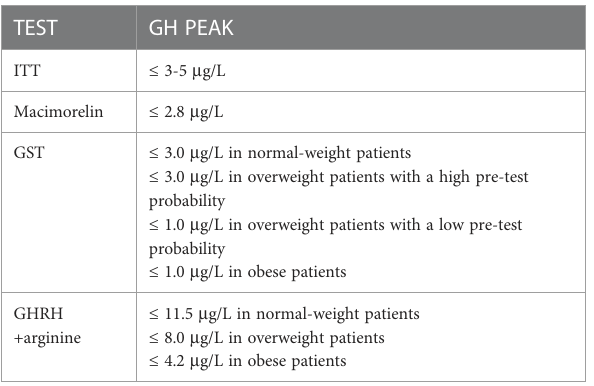
TABLE 6 Growth Hormone De fi ciency diagnostic cut-offs with different